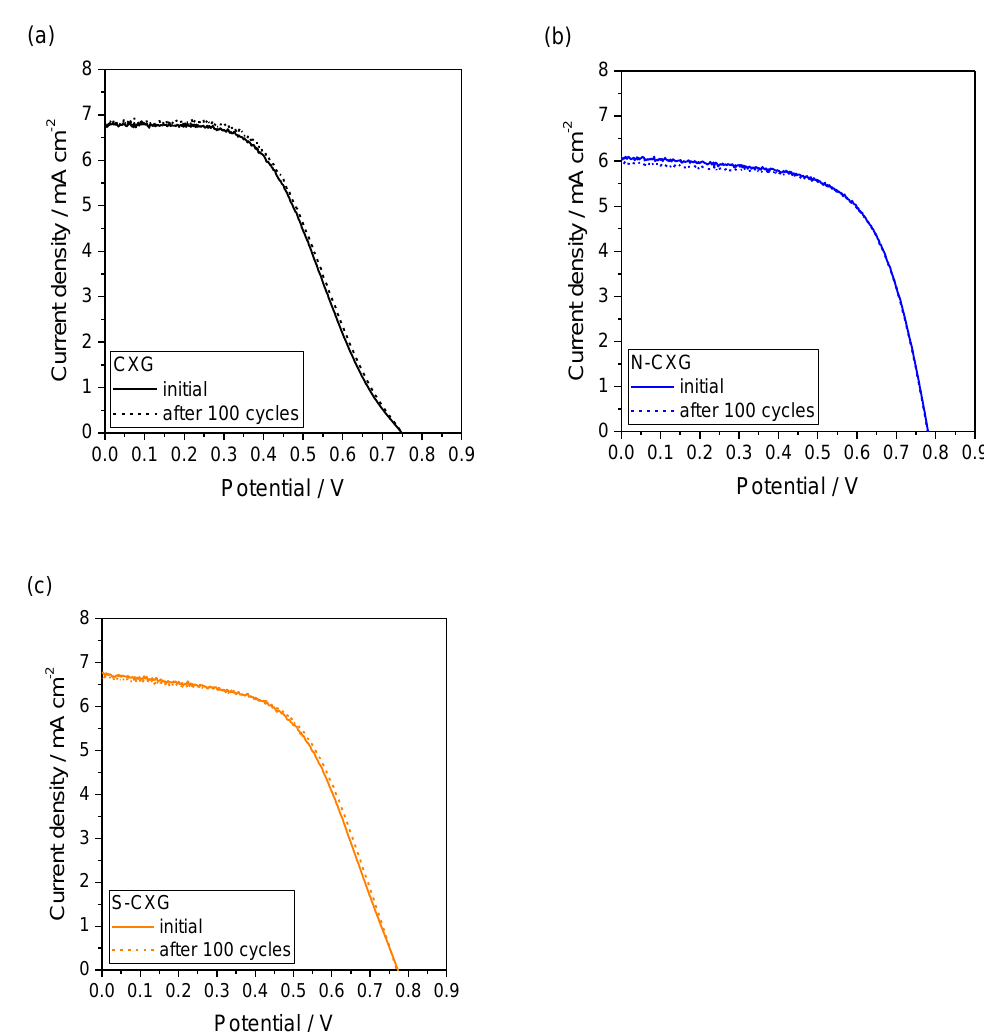
Figure 6. DSSC polarization curves at the beginning and after 100 cyclic voltammograms for ( a ) CXG; ( b ) N-CXG; and ( c ) S-CXG, used as counter electrode.